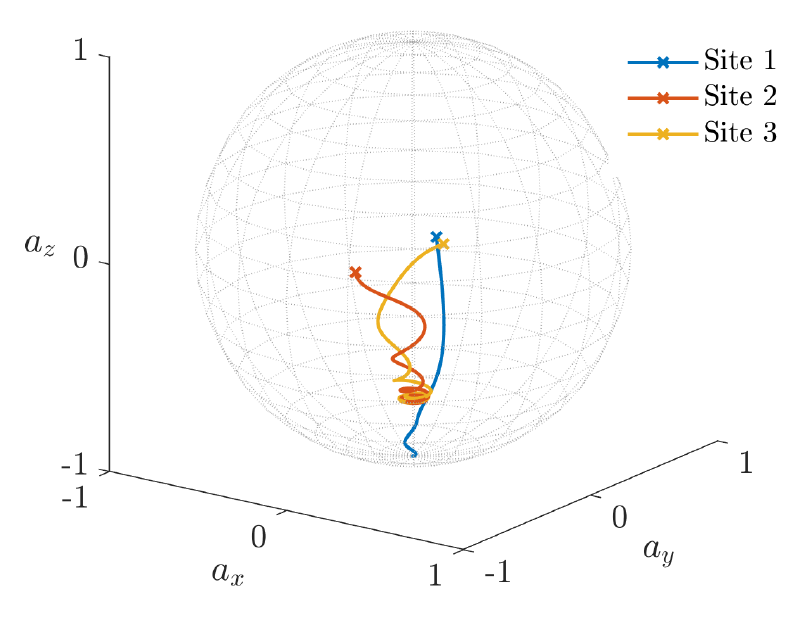
Figure 5: Bloch sphere representation of the evolution of the model described in Sec. 6.1 with parameters ∆ = 1, B = 0.5 and γ = 2 and a randomly chosen initial state. We define the reduced density matrix for each site by taking the partial trace over the = Tr ( ρ ) . We then find and plot the corresponding Bloch sphere other sites, ρ k A , B (cid:54) = k = 1 ( (cid:73) + (cid:126) a ( k ) · (cid:126)σ ) where (cid:126)σ are the usual representation, (cid:126) a ( k ) for the reduced states as ρ k 2 Pauli matrices. The initial point of each trajectory is marked with a cross. We see the second and third sites reach a limit cycle which they orbit perfectly out of phase, while the first site rapidly decays to the (cid:126) a = ( 0,0,1 ) point on the Bloch sphere. This demonstrates the anti-synchronization between only sites 2 and 3. Note that since the reduced states are note pure the trajectories live within the